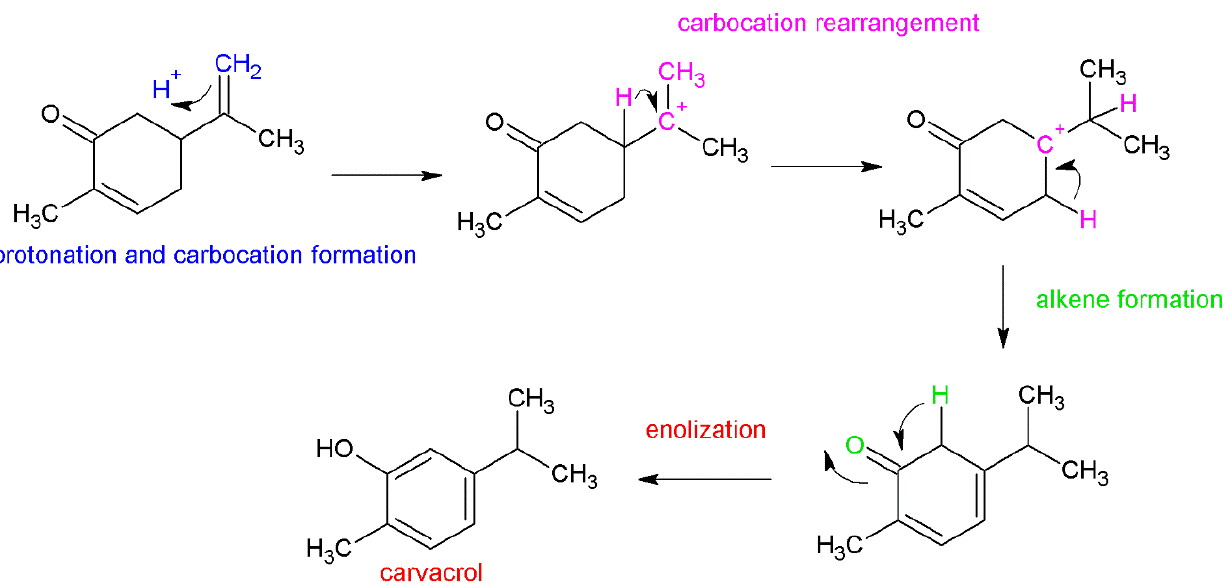
Figure 8. Proposed reaction mechanism for carvacrol formation from carvone.